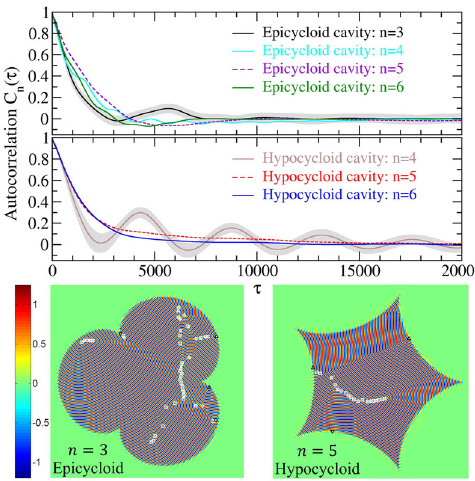
Fig. 3 Time correlation of defect density in closed cavities. Autocorrelation function C n ( τ ) of defect number density for various epicycloid and hypocycloid closed cavities at v 0 = 0.31. Also shown are two sample snapshots of the ψ fi eld spatial pro fi le, with the scale of ψ indicated by the color bar and the same symbol labeling of defects as that in Fig.